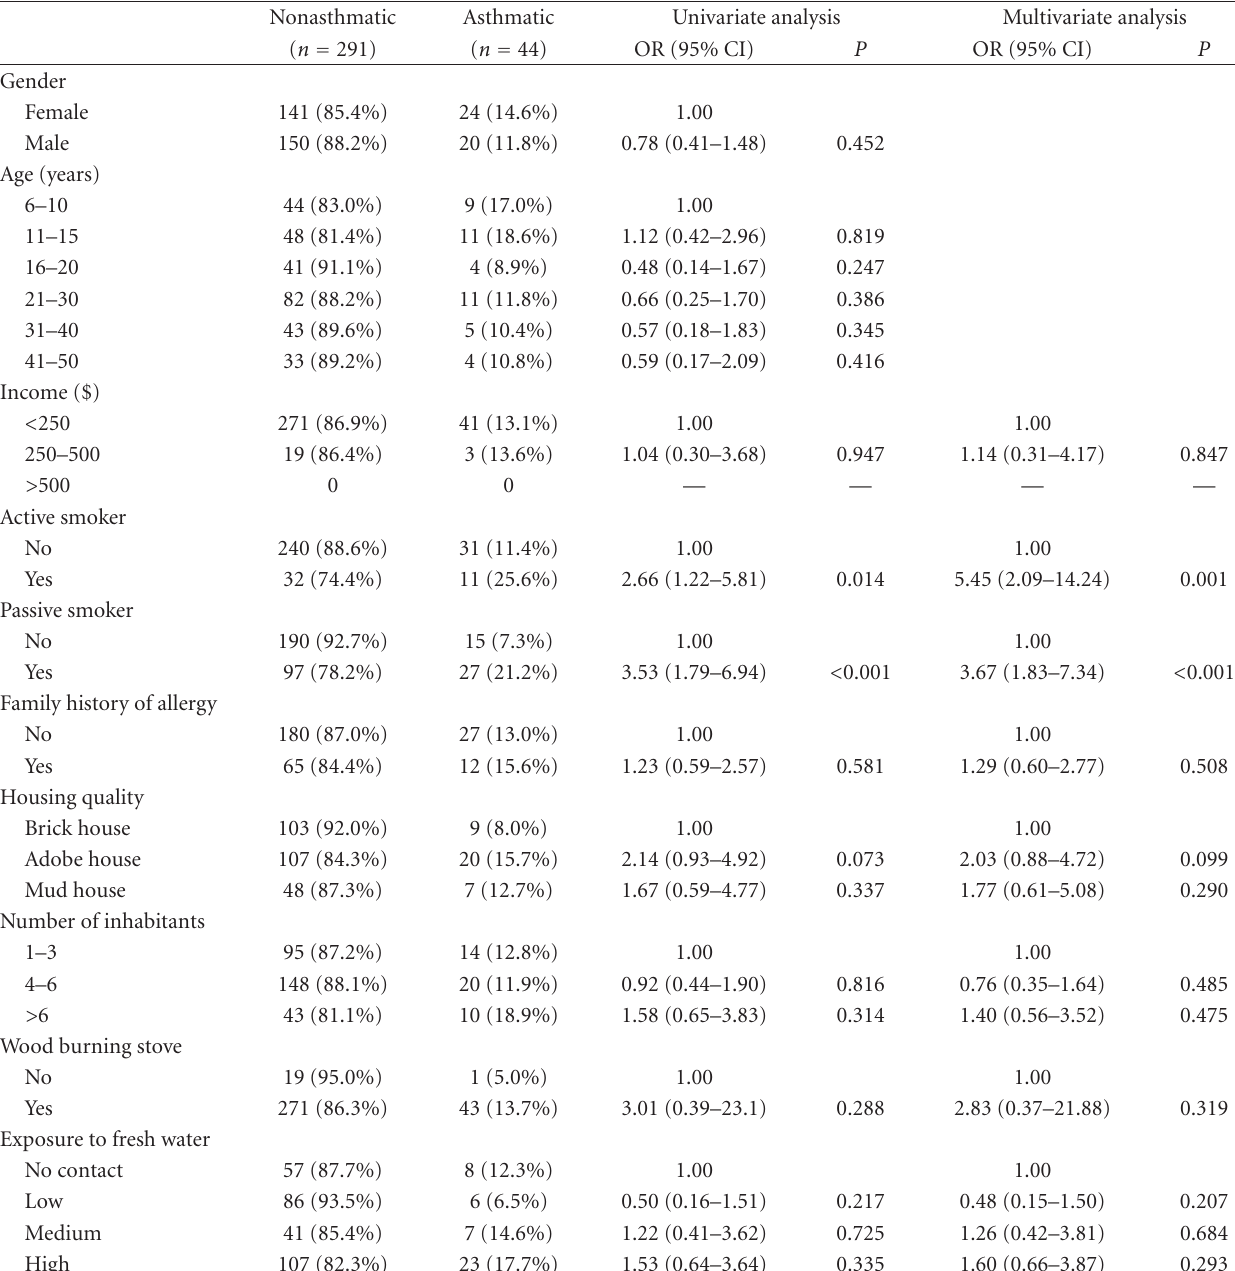
Table 2: Univariate and multivariate analysis for the association between asthma and possible risk or protector factors.